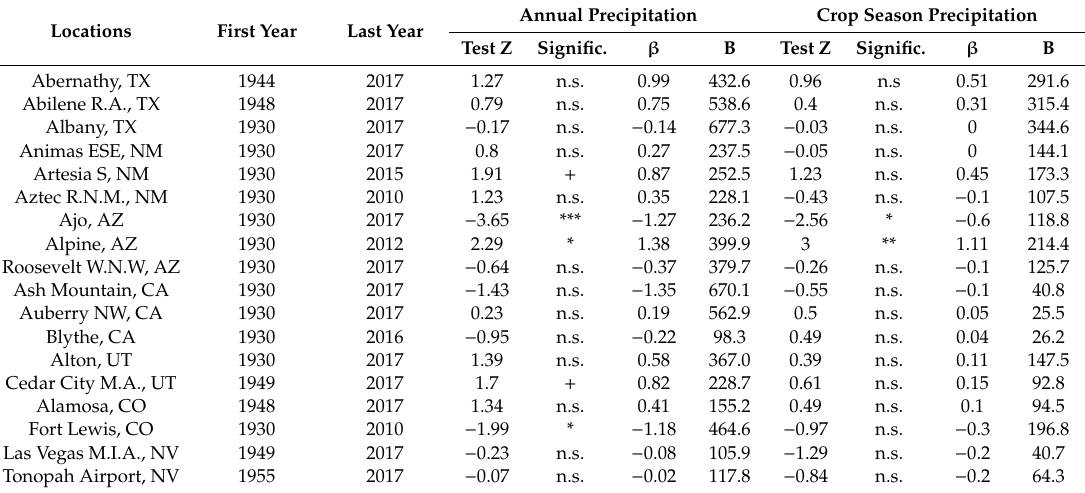
Table 2. Summary of the Mann–Kendall trend test for annual and crop season precipitation. Locations